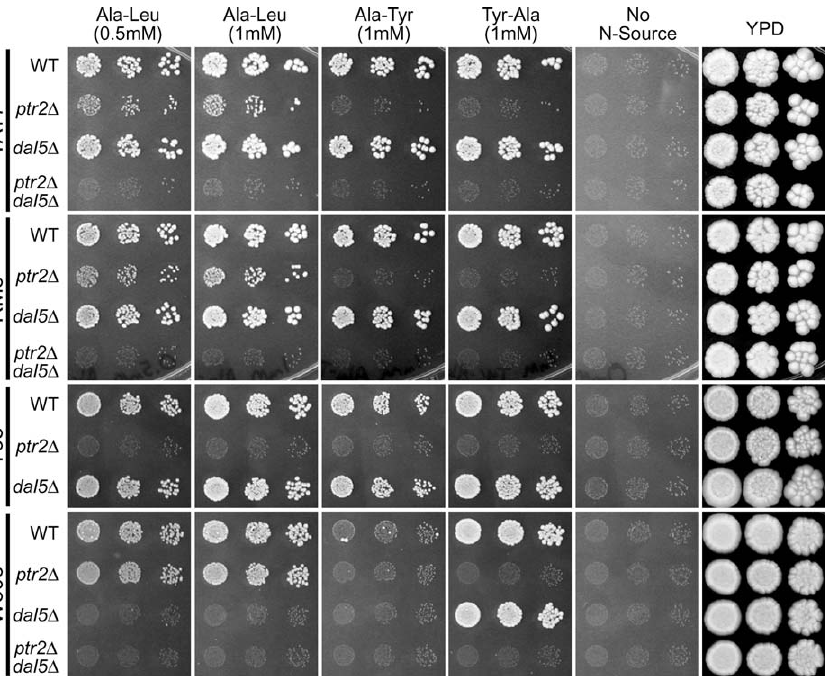
Figure 4. The Relative Contributions of Dal5p and Ptr2p to Dipeptide Utilization Vary among Strains of S. cerevisiae Strains were cultured on YPD plates, as with the PM assays, and then suspended in water at a concentration of approximately 3.5 3 10 6 cells/ml and plated as 1 3 , 5 3 , and 25 3 dilutions (from left to right). Each plate contained MM plus the nitrogen source indicated at the top of the column (with the exception of the far right column, in which YPD plates were used). Plates were incubated at 30 8 C for 4 d and then photographed. A Y55- ptr2 D dal5 D double mutant was not tested, since deletion of PTR2 alone was sufficient to eliminate dipeptide utilization.